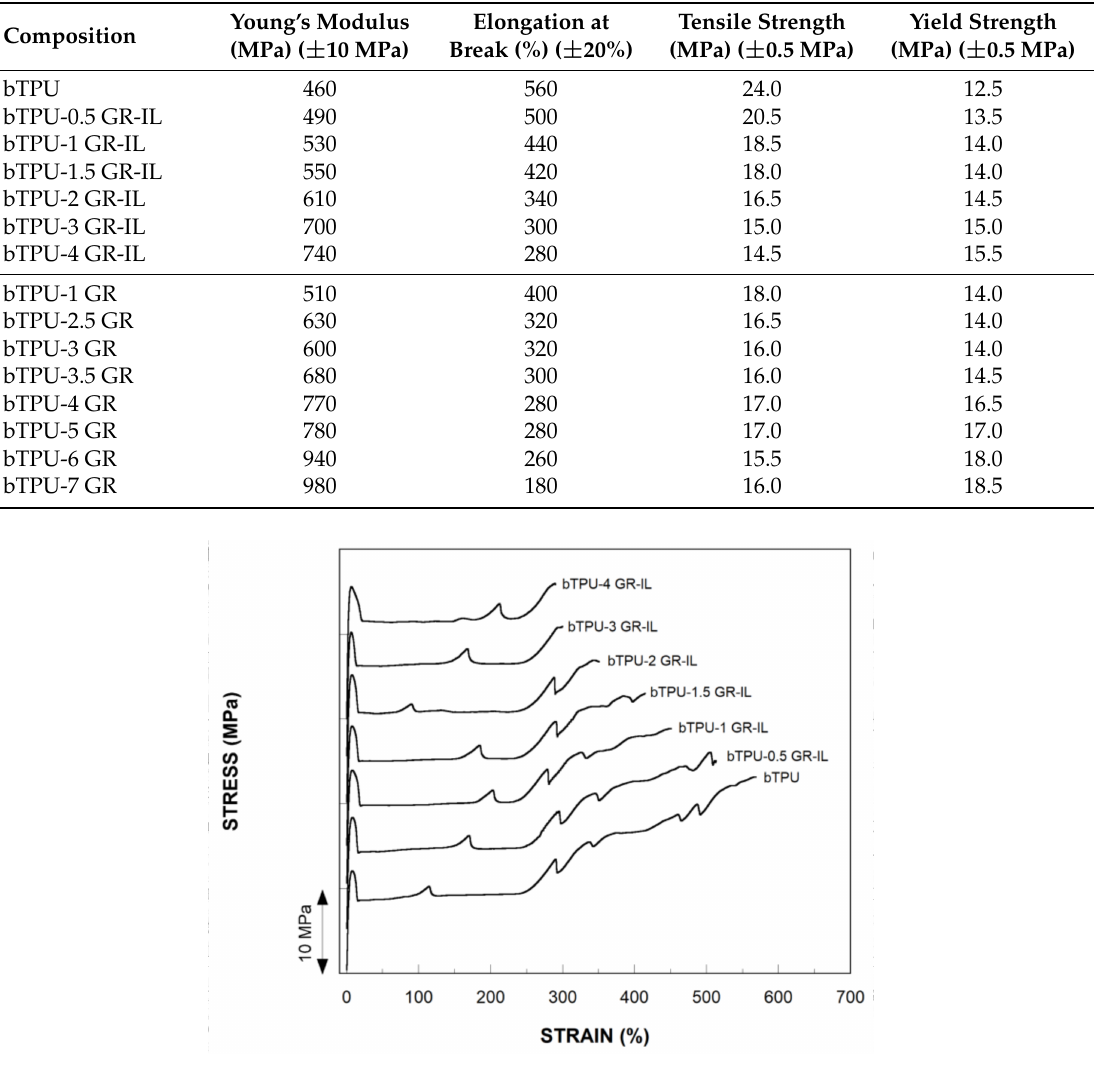
Figure 4. The stress–strain curves of the bTPU/GR-IL NCs. The curves are shifted along the vertical